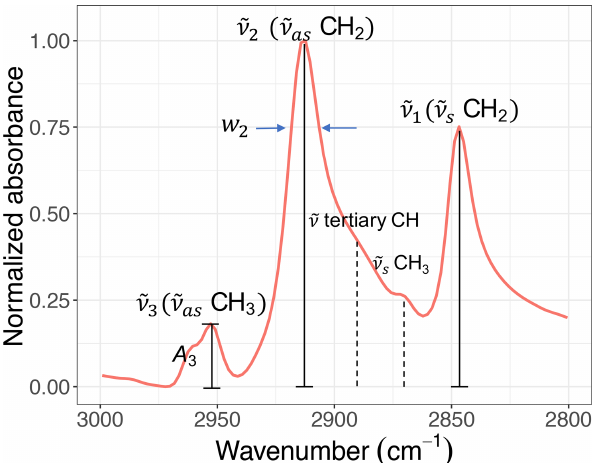
Figure 5. A sample C − H spectrum showing the convention of peak parameters used in this study. The symmetric CH 2 ( ˜ ν s CH 2 ) wavenumber is denoted by ˜ ν 1 . The asymmetric CH 2 ( ˜ ν as CH 2 ) wavenumber is denoted by ˜ ν 2 and the asymmetric CH 3 ( ˜ ν as CH 3 ) wavenumber by ˜ ν 3 . Absorbance and width of the i th peak are also denoted by A i and w i ,